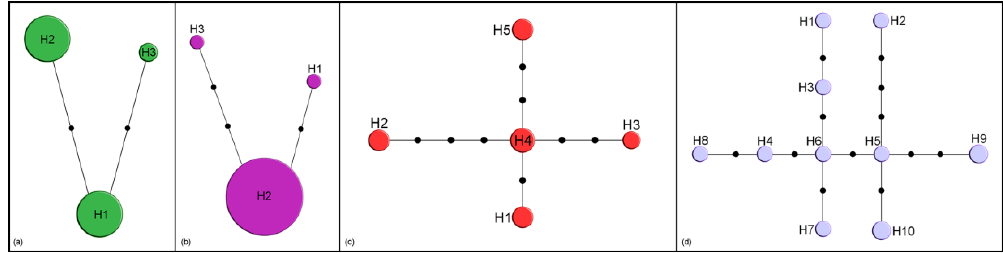
Figure 2. Haplotype networks based on cytochrome c oxidase subunit I ( COI ) sequences. Size of circles indicates the number of specimens with a haplotype; black dots represent one nucleotide substitution: ( a ) M. crepidis ; ( b ) M. caricis ; ( c ) M. brachyradius ; ( d ) F. pseudoplatani